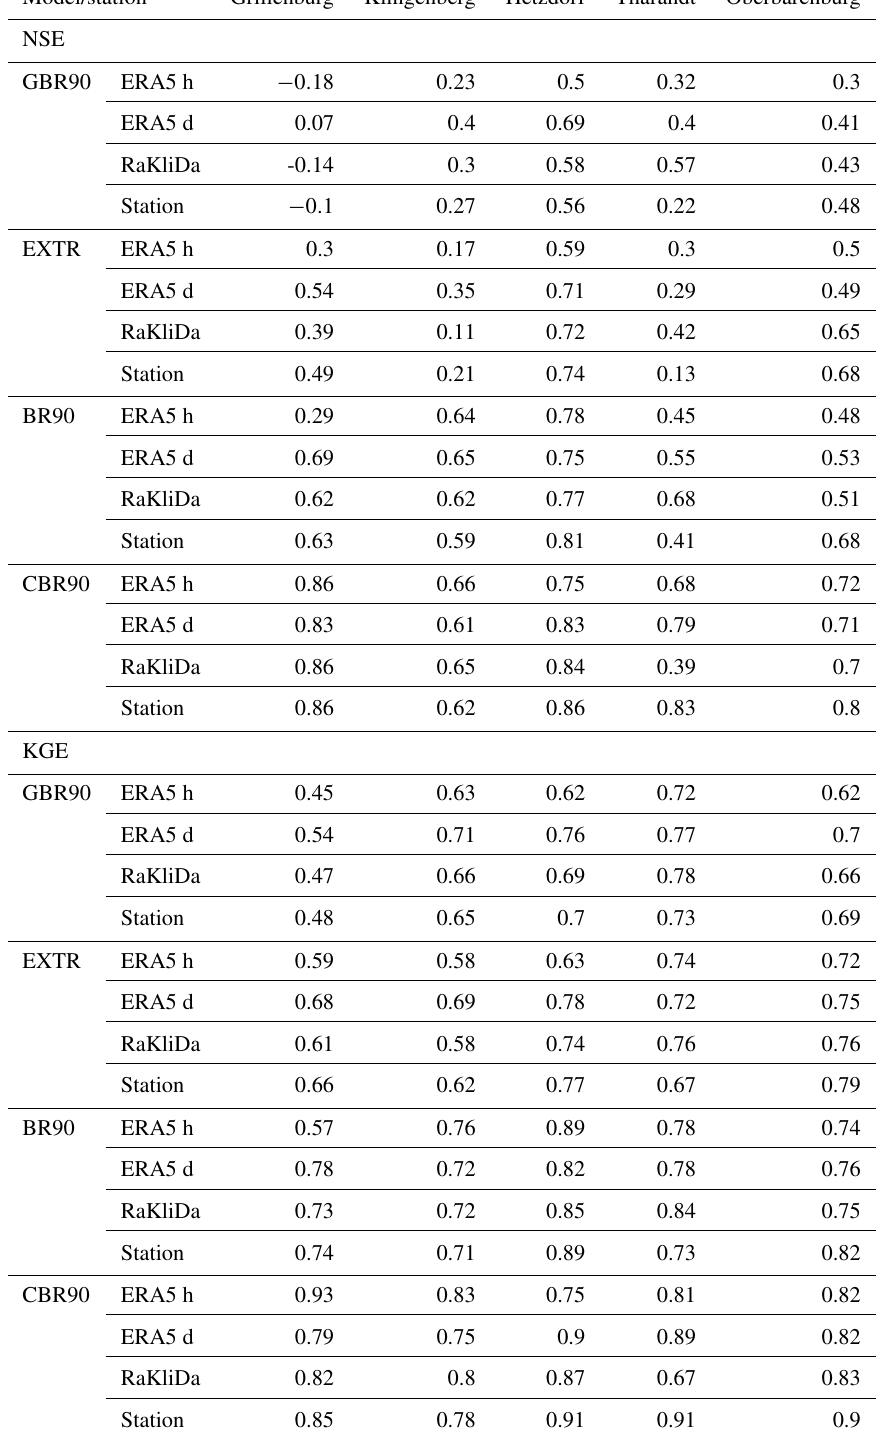
Table E5. Monthly evaporation skill scores for the vegetation period.